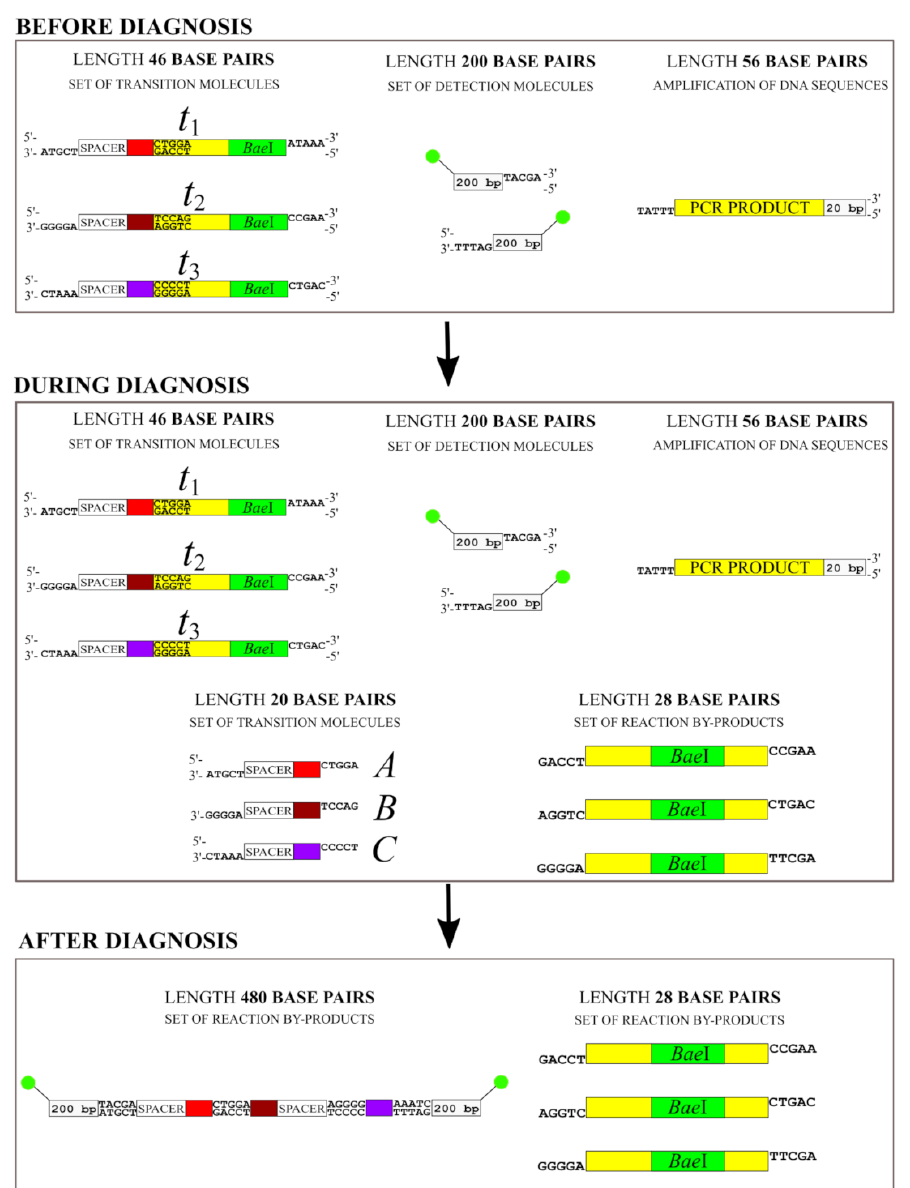
Figure A2. The list of DNA chain lengths before, during and after molecular diagnosis by means of a biochip based on a biomolecular computer. The length of DNA strands before the diagnosis is: 200 bp, 56 bp, and 46 bp, while after the molecular diagnosis it is: 480 bp, and 28 bp. The fluorescence mechanism is used, in which fluorescence occurs when a DNA chain of 480 appears in the solution. The color markings are described in Figure